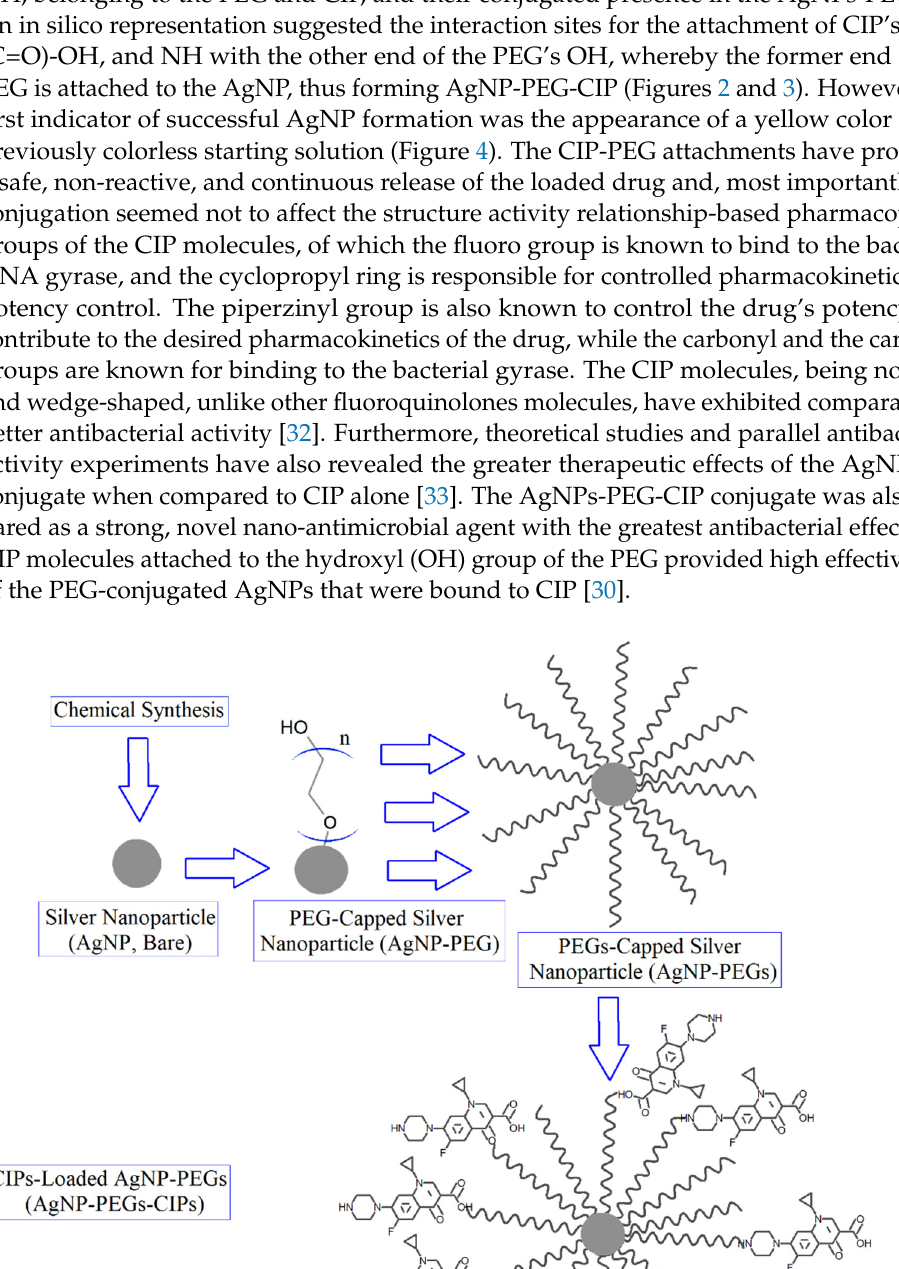
Figure 2. Chemical structure models of the AgNP-PEG-CIP (two methylene units,-CH 2 -CH 2 , of the AgNP-PEG, i.e., AgNP-O-(CH 2 -CH 2 )n-O-CIP interactions, showing OH, NH, and C=O sites); blue and red encased area represent PEG and CIP, respectively; the circle represents the AgNPs; ( A ) represents –(C=O)-OH-based CIP conjugation, ( B ) represents piperazinyl NH-based CIP conjugation, and ( C ) represents (HO-)-C=O-based CIP conjugation.